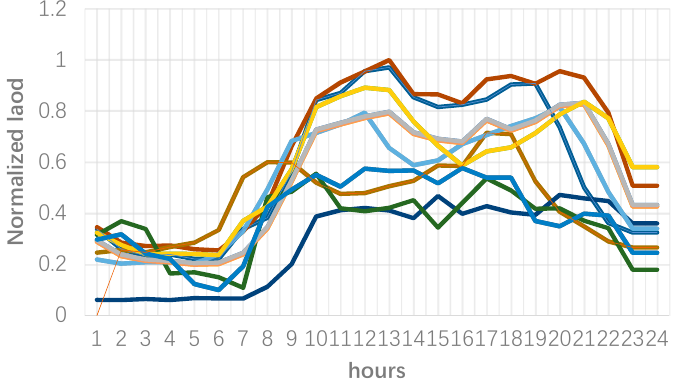
Figure 7. Load curves of consumers in cluster 2.